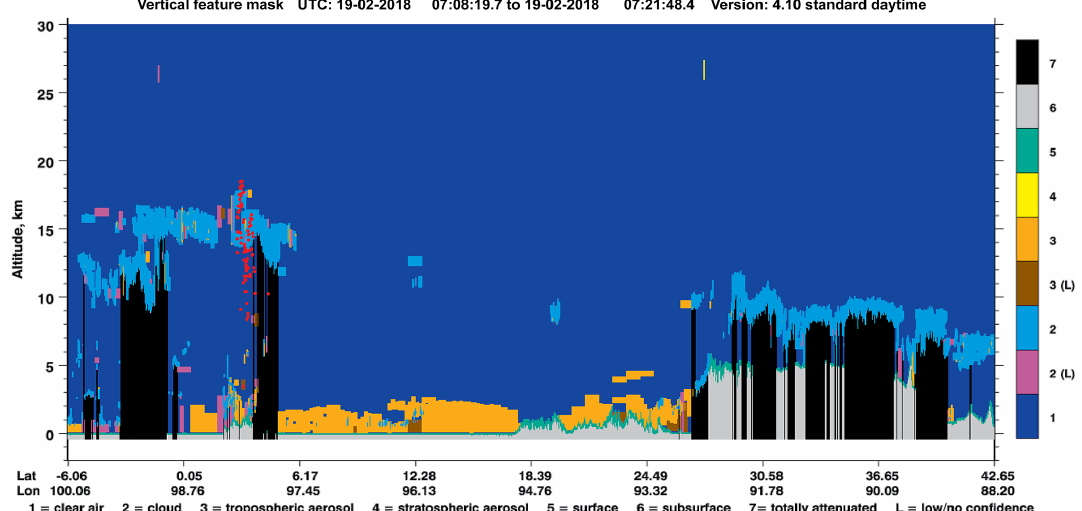
Figure 7. CALIOP/CALIPSO vertical feature mask for the measurement of the Sinabung volcanic eruption on 19 February 2018 at around 07:15UTC. Red dots show the retrieved LH for pixels with SO 2 VCD values greater than or equal to 20DU. The ground track of the CALIPSO measurements is shown in Fig. 6. The volcano is located at 3.17 ◦ N, 98.39 ◦ E. The plume is clearly visible in the left section of the image. Note that the classification scheme sometimes cannot pick up the volcanic ash or sulfate aerosol because of competing clouds. CALIPSO image credit: